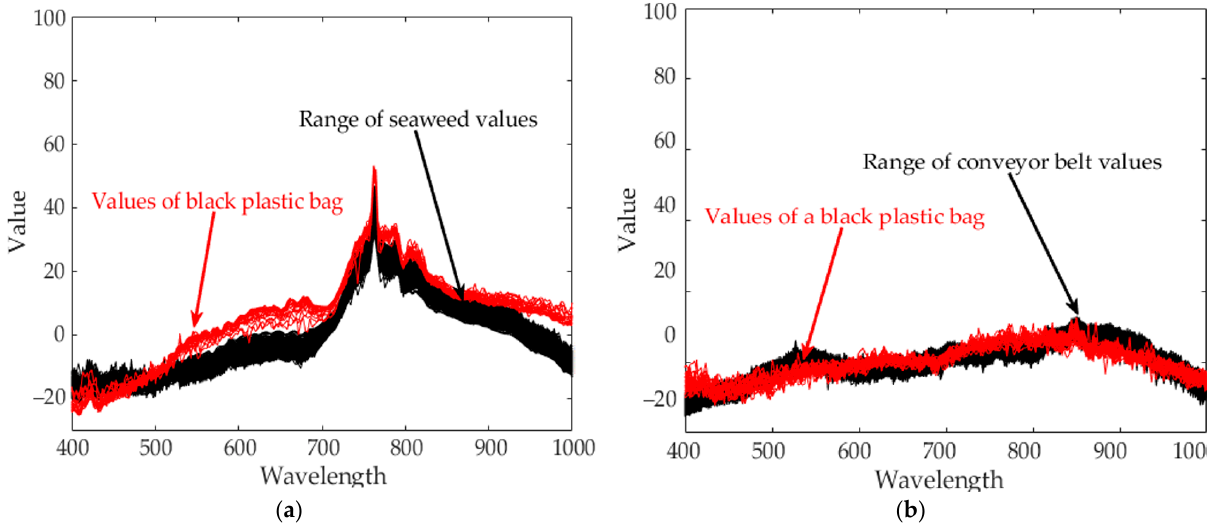
Figure 10. The range of the reference data and the value of the black plastic bag obtained after standardizing. ( a ) About seaweed pixels ( b ) About conveyor belt pixels.